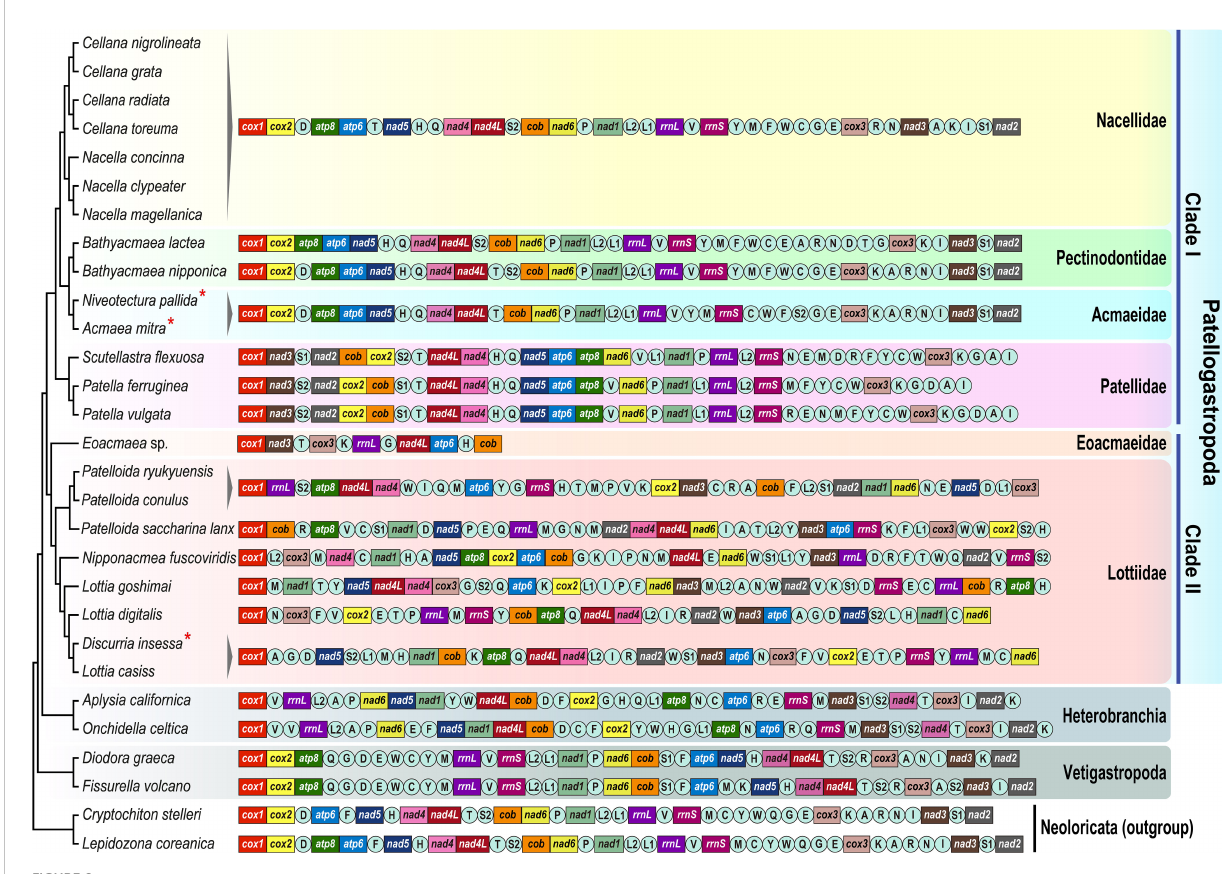
FIGURE 2 Linearized mitochondrial gene arrangement of Patellogastropoda and other gastropod (Heterobranachia and Vetigastropoda) species lay alongside the phylogenetic tree (see Figure 1 for their detailed relationships). The tRNA genes are labeled by single-letter abbreviations of the amino acid code. An asterisk (*) denotes mtDNA sequences newly determined in this